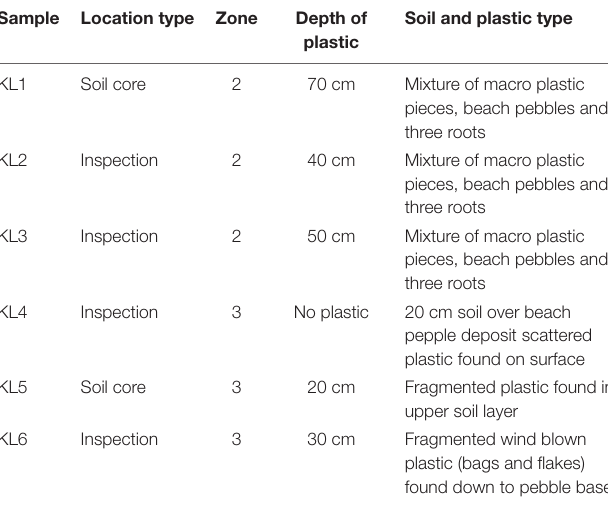
TABLE 2 | Samples collected at case 2